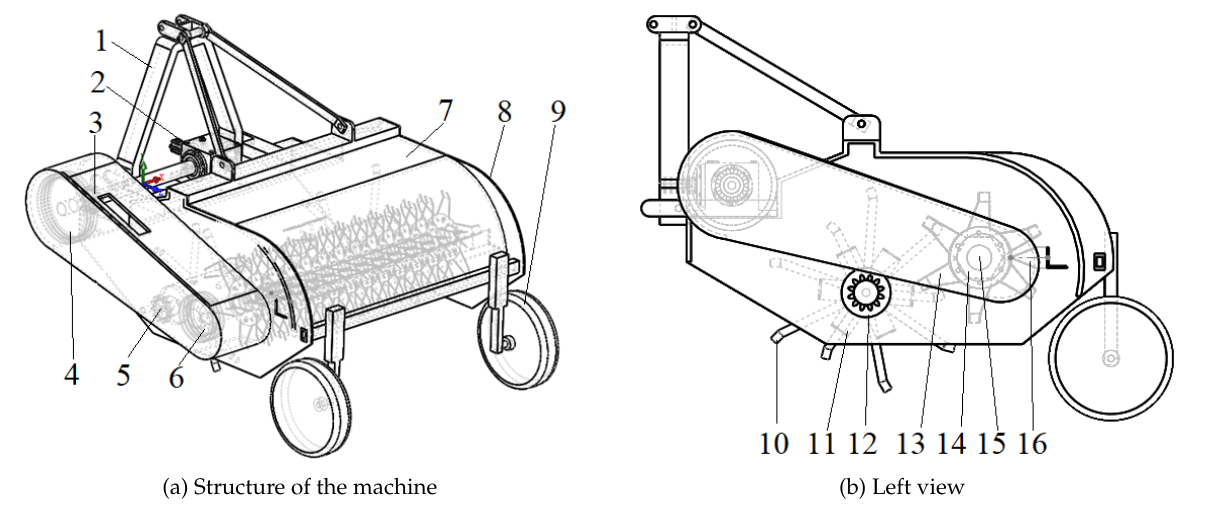
Fig. 1. Structure of double-roller sweet potato vine crushing and returning